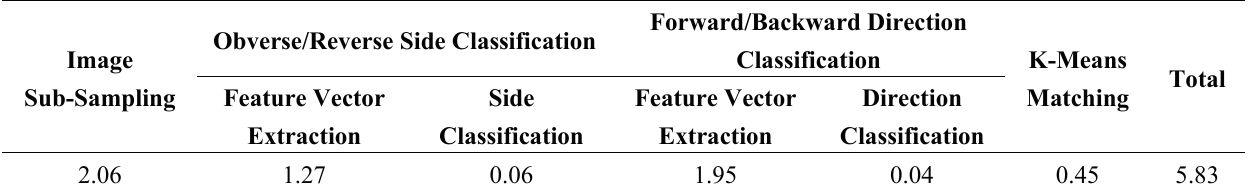
Table 8. Processing time of the proposed method on PC (unit: ms).